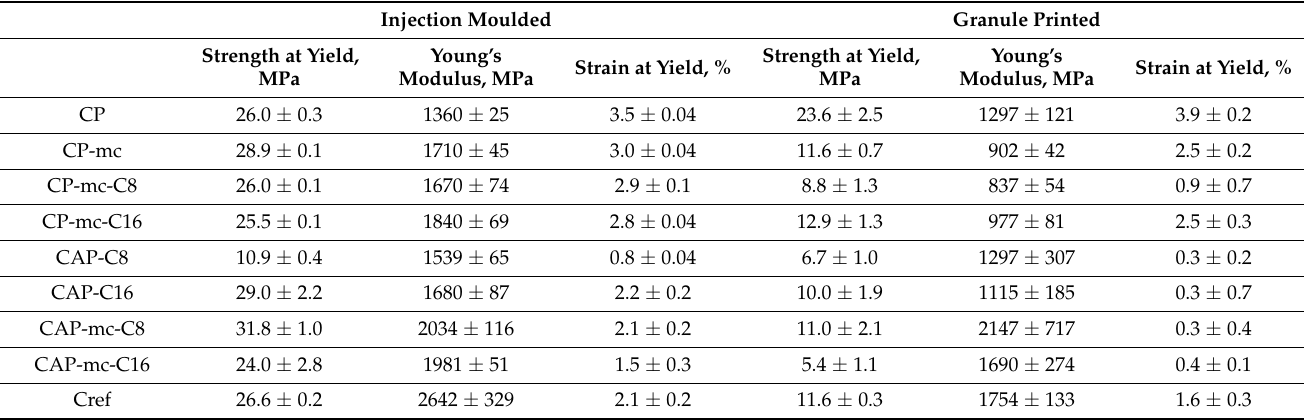
Table 5. Results from tensile strength test for injection molded and 3D printed materials. Injection